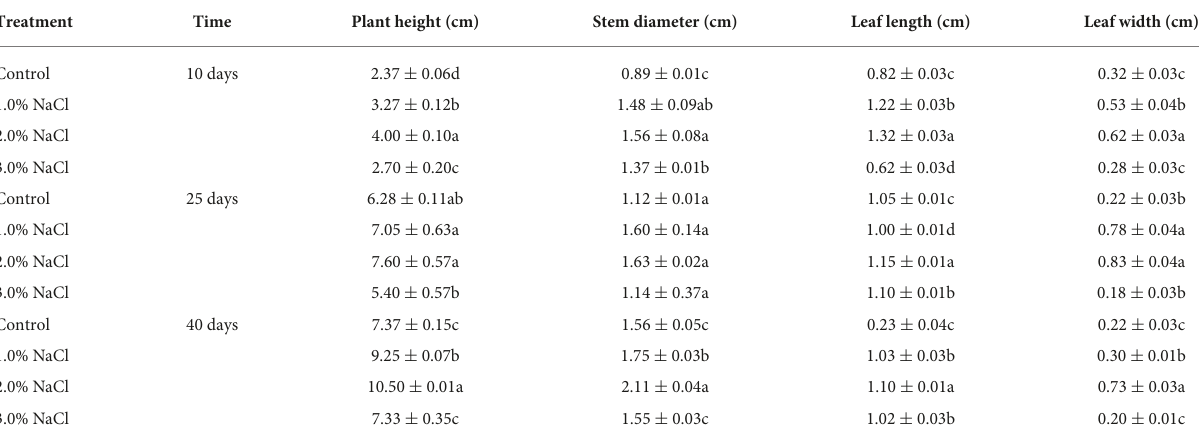
TABLE 1 Effects of different concentration salt stress on the increment in growth indexes of S. caseolaris seedlings.